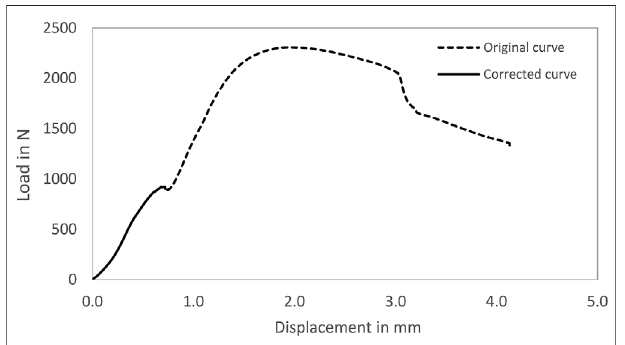
FIGURE 3 | Exemplary original (dotted line) and corrected load – displacement curve (continuous line; fi rst force drop) of a double- notched compression test specimen (30% Danu fi l 3.3 dtex/epoxy).